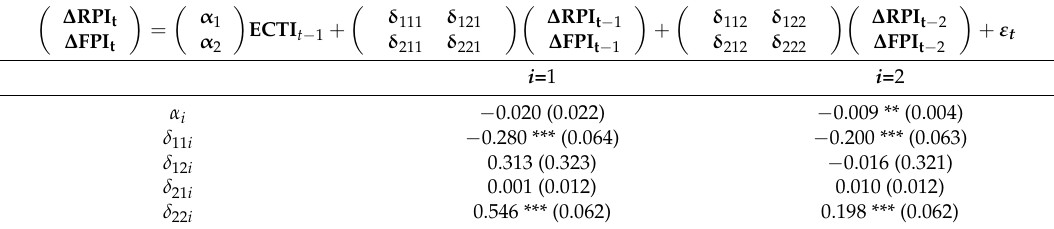
Table 7. Short-run estimates for PDO cheese.